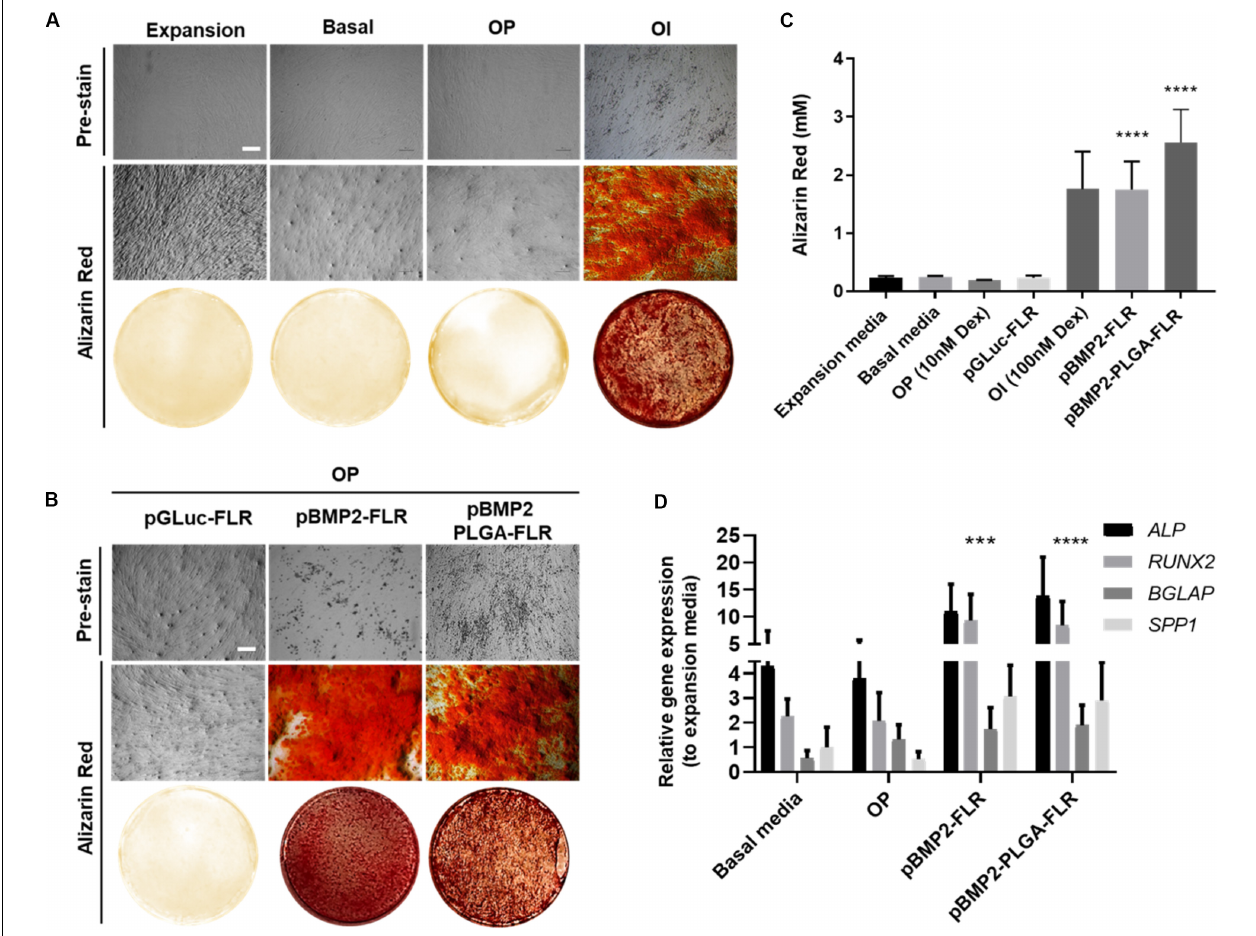
FIGURE 5 | Osteogenic differentiation as a result of pBMP2 encapsulated PLGA- GET delivery. (A) Phase contrast microscopic images (pre-stain) and Alizarin Red stained microscopic and whole well images of control IHMSCs in expansion, basal, OP and OI media. (B) Phase contrast microscopic images (pre-stain) and Alizarin Red stained microscopic and whole well images produced dense calcium deposits in cultures transfected with pBMP2-FLR and pBMP2 encapsulated PLGA NPs in comparison to controls. Cells were cultured at 35k cells in 24-well plate format. Scale bar 100 µ m. (C) Quantification of Alizarin Red stained calcium nodules; (mM) fold increase in dye absorbed calcium of transfected cultures in comparison to controls. (D) Significant activation of the osteogenic genes: ALP (Alkaline Phosphatase), RUNX2 (Runt Related Transcription Factor 2), BGLAP (Bone Gamma-Carboxyglutamate Protein) also called Osteocalcin , and SPP1 (Secreted Phosphoprotein 1) also called Osteopontin at week four from IHMSCs either treated with pBMP2-FLR NPs or pBMP2-encapsulated PLGA-FLR NPs in comparison to non-transfected cells. The graph was plotted based on expression fold change to cells cultured in expansion media only. One-way and two-way Anova statistical analysis were used to generate the graphs followed by Tukey test to determine significant differences between each mean. The data represented as mean ± SD. Where significance was *** or ****, P -value was, 0.0002 or < 0.0001